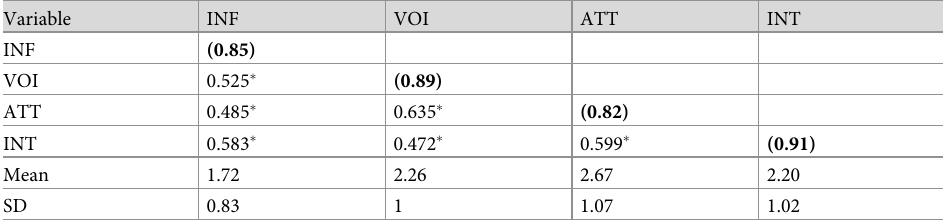
Table 3. Mean, standard deviation, reliability and Spearman correlation of individual level variables † . Variable